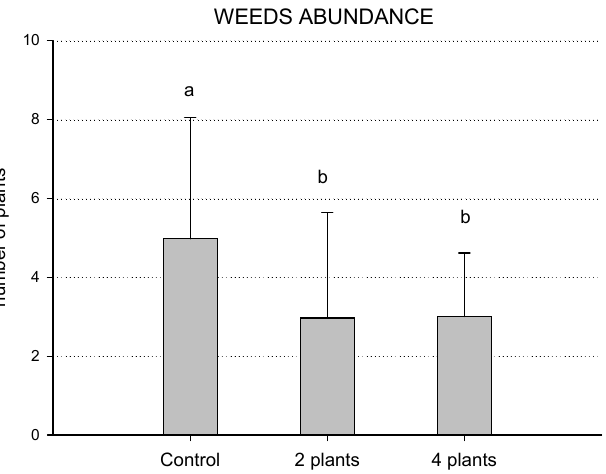
Figure 4. Number of weed plants (abundance) found in 0.25 m 2 in the row (mean ± SD). Letters indicate significant differences of Tukey’s HSD test.